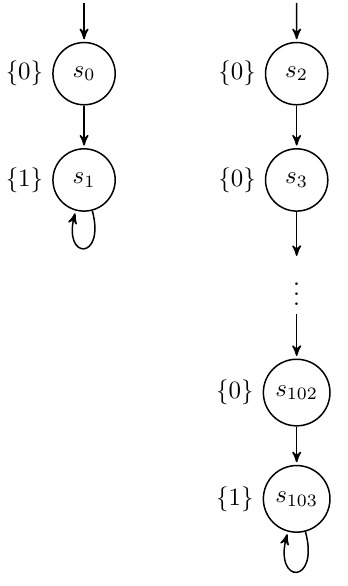
Figure 4. Kripke structure of the program P5